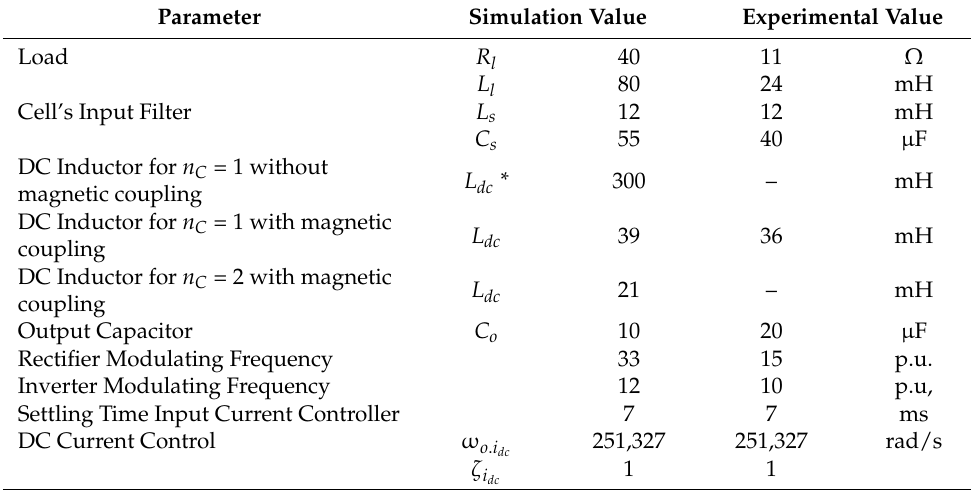
Table 2. Simulation and experimental